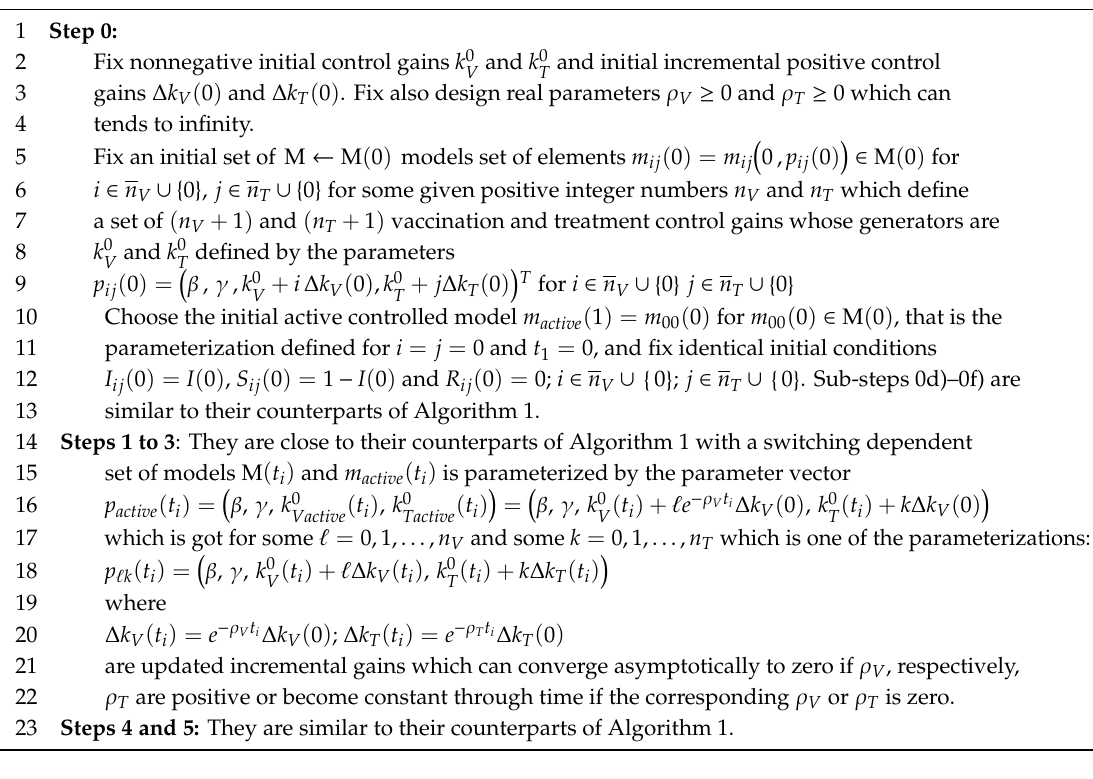
Algorithm 3. The vaccination and treatment control gains candidates are selected on line by incremental variations of the active